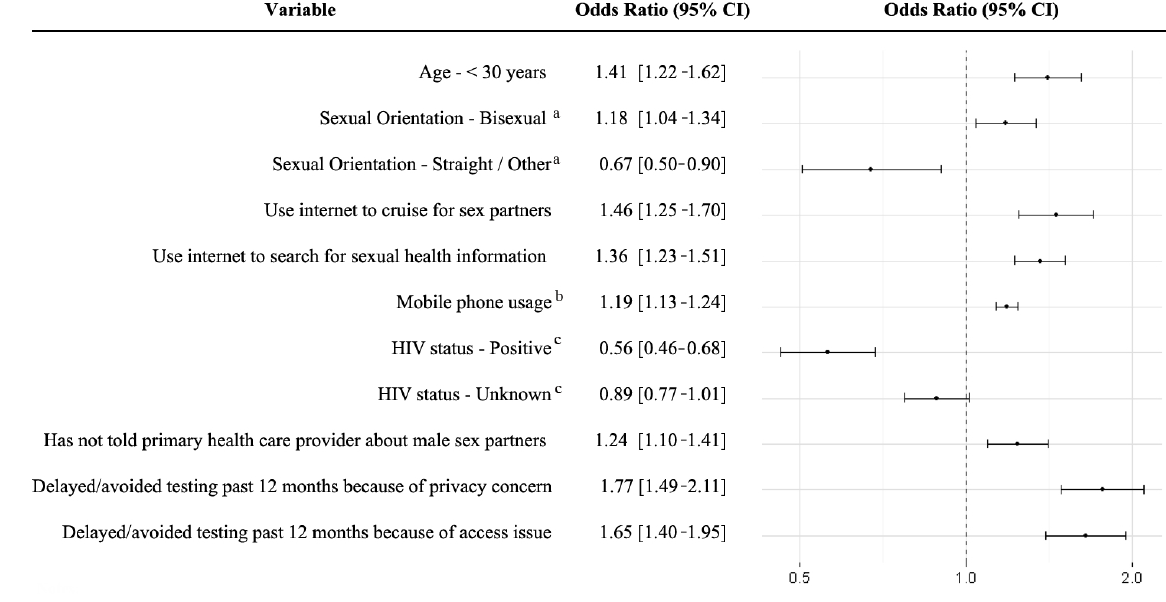
Table 1. Greatest perceived benefit to Internet-based STI and HIV testing among the survey sample of Canadian gay and bisexual men.